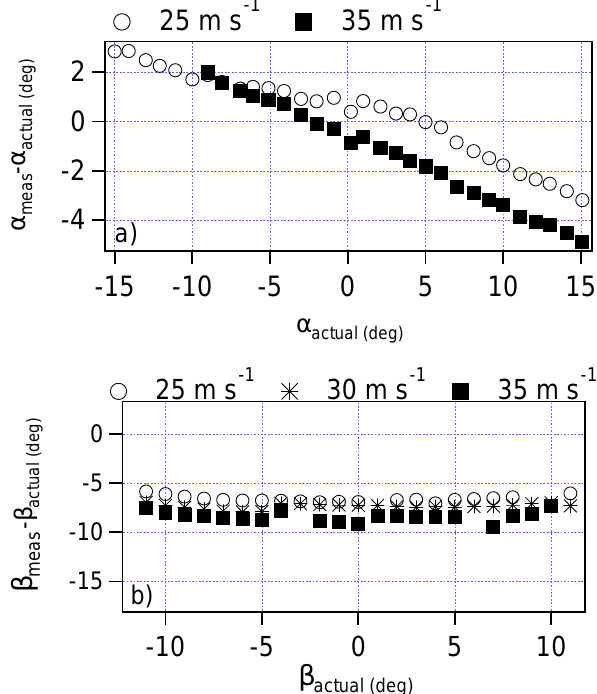
Fig. 2. Gust probe windtunnel calibrations for modulation of (a) attack angle, α from +/ − 15 and (b) sideslip angle, β , from +/ − 11 at True air speeds comparable to those measured during